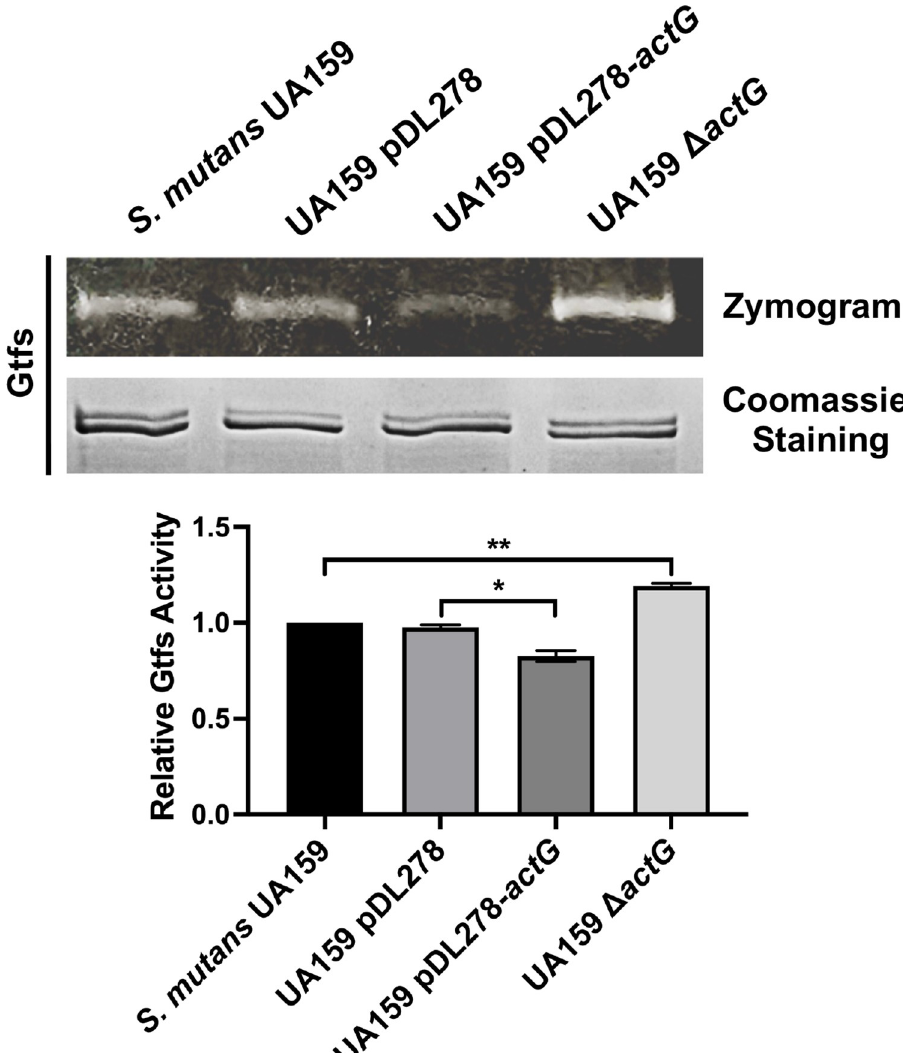
Fig 4. Effect of actG on Gtfs activities of S . mutans . Gtfs were analyzed for protein amount by Coomassie staining (upper and below) and glucan production by incubating gels with sucrose (upper and above), respectively. The band signals were quantified with Image J software and normalized to the control. Results are presented as mean ± SD ( � P < 0.05 or �� P <